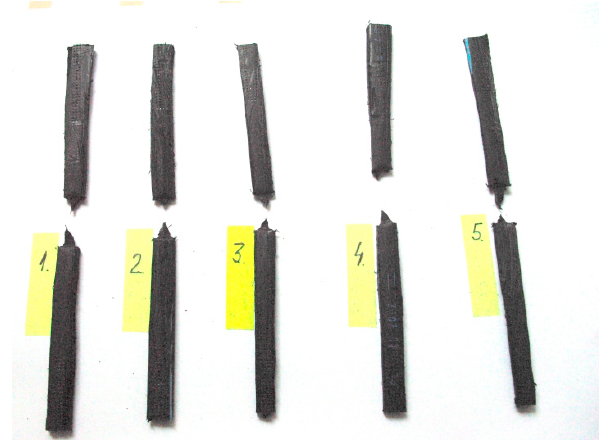
Figure 8. Samples of HDPE pipe Ф 90 × 6 broken at traction.